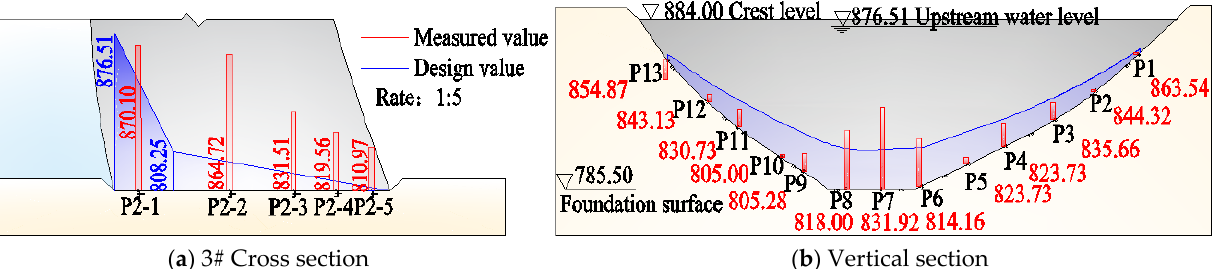
Figure 10. Measured uplift pressure under the high reservoir water level.